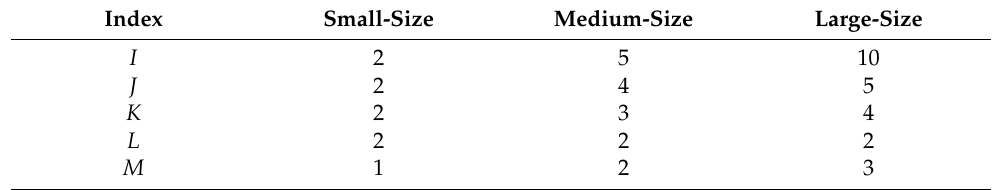
Table 4. Dimensions of test